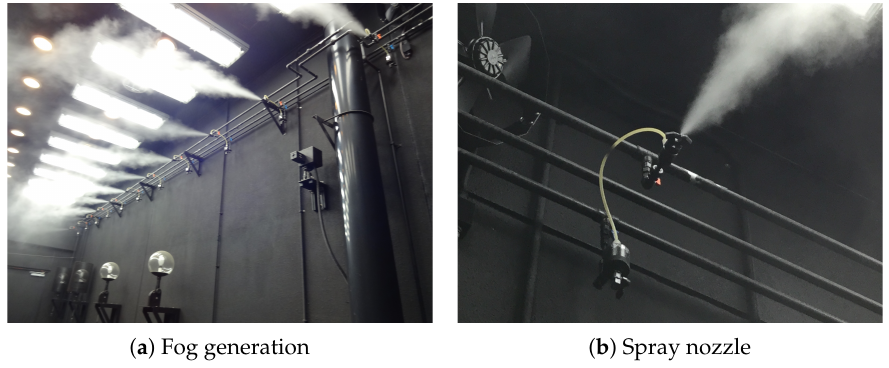
Figure 3. Artificial fog generation by spray